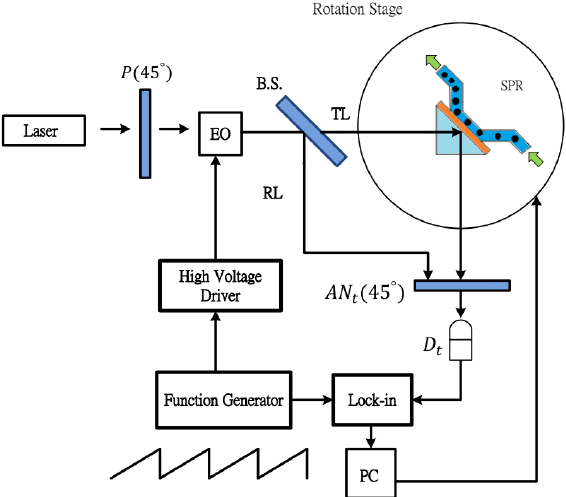
Figure 2. Schematic of the experimental setup in the Kretschmann configuration for refractive index measurements. P: polarizer, BS: beam splitter, AN: analyzer, D: detector, TL: test light, RL: reference